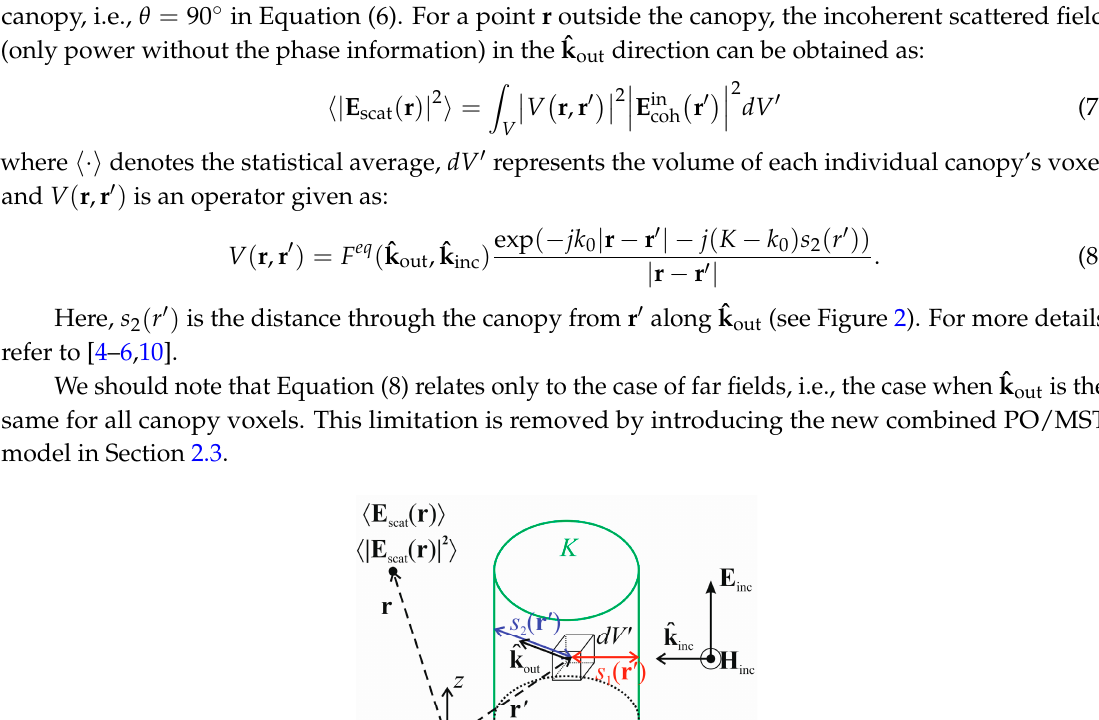
( r (cid:48) ) depends on the distance coh